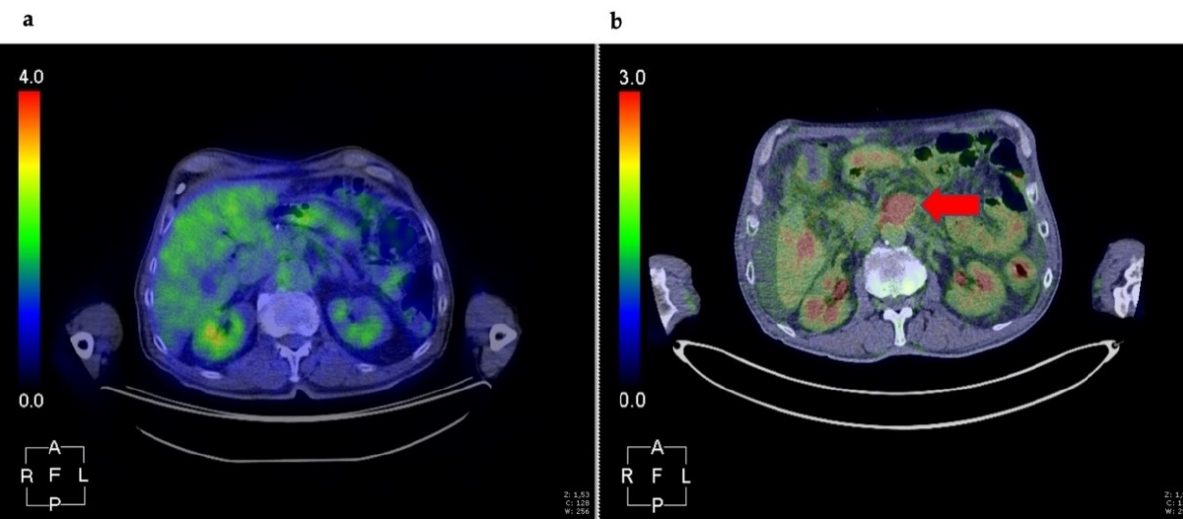
Figure 1. Patient diagnosed with PC (head), received six cycles of NAT (May–October 2019) and subsequent resection (December 2019). First PET/CT evaluation was performed in July 2020 for suspicious local relapse. The result was negative ( a ). During follow-up, in June 2021, a second scan revealed a preaortic mass (red arrow) compatible with disease relapse ( b ). Figure is property of the authors.